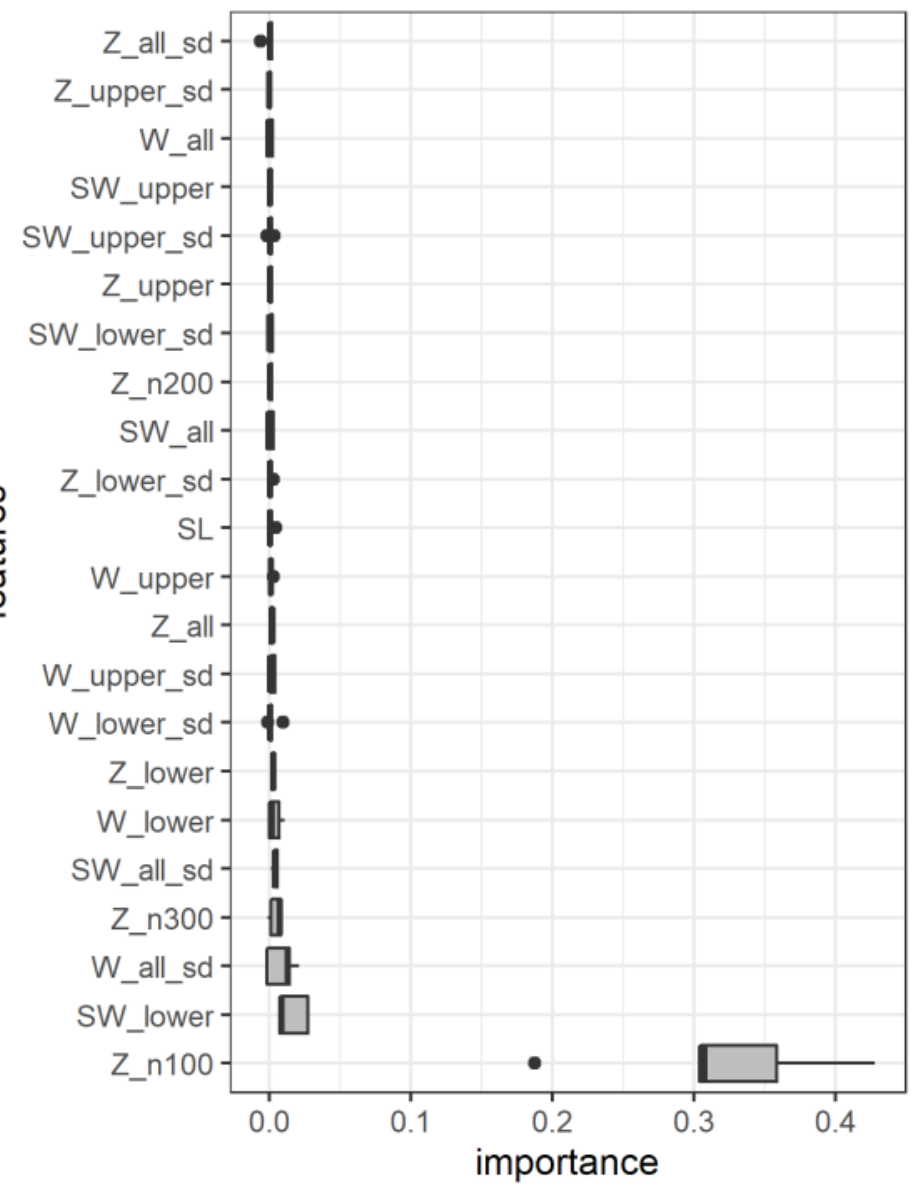
Figure 4. The importance of individual features ordered by the mean value of permutation feature importance (PFI) for all 5 folds of the cross-validation. It shows the negative difference in AUC performance values between the original and modified dataset to receive positive PFI values. The left (right) hinges represent the first (third) quartiles, while the whiskers extend from the hinges to the smallest (largest) value no further than 1.5 times the interquartile range from the hinge, any value out of this range is considered as an outlier and is represented with a black